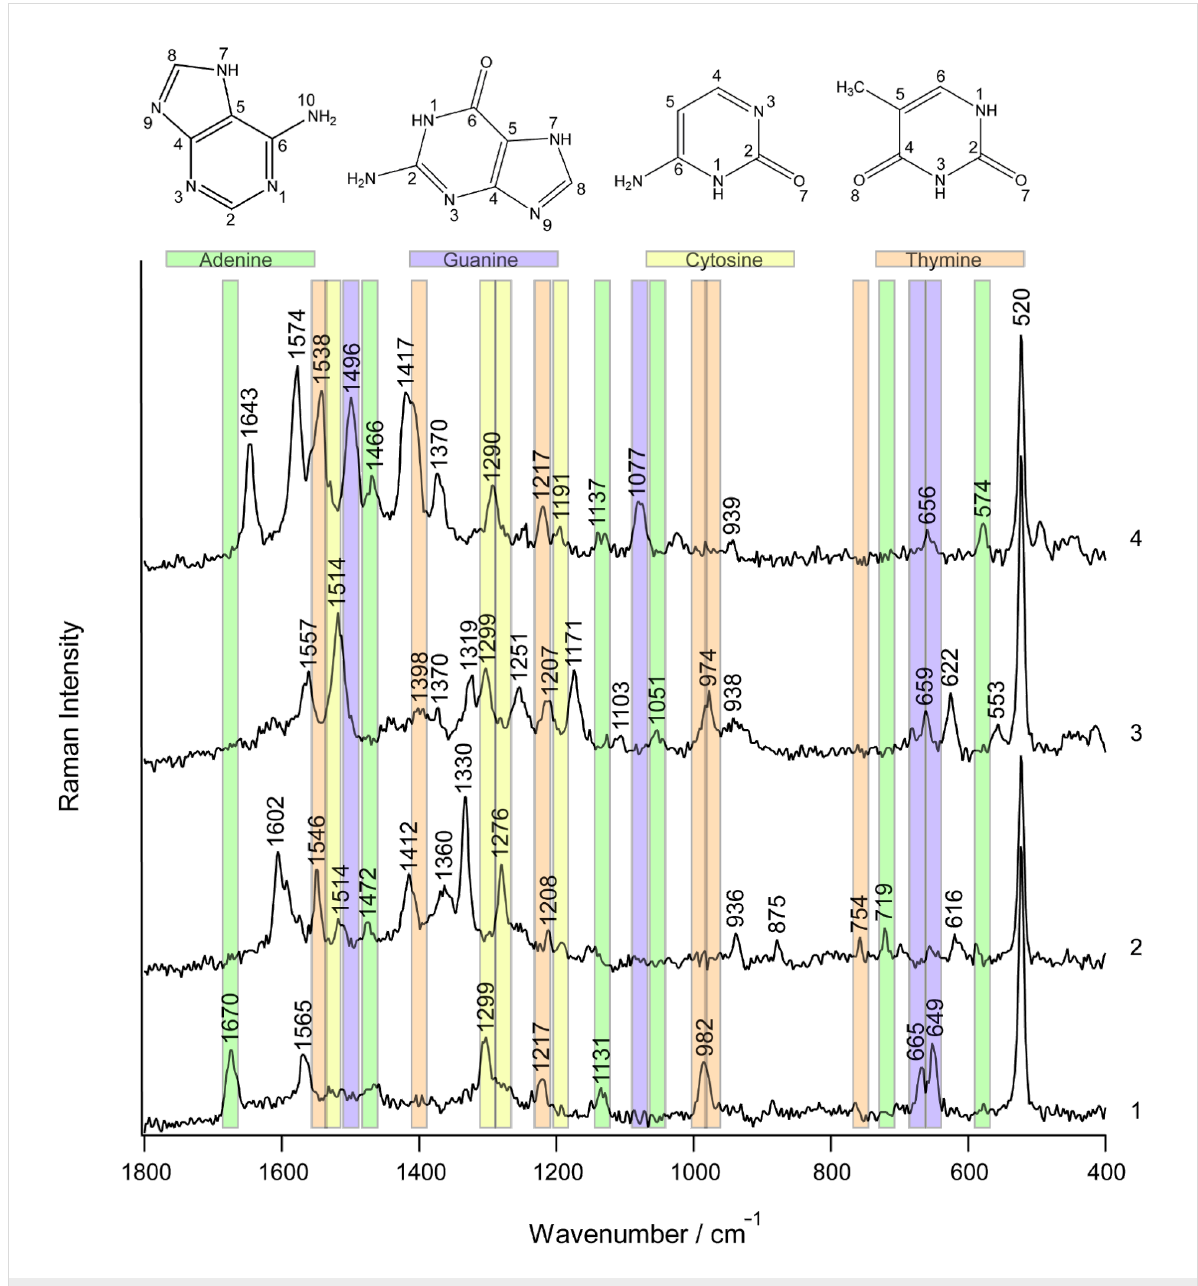
Figure 5: TERS spectra measured at four positions on single stranded calf thymus DNA. Unambiguously assignable bands are highlighted.